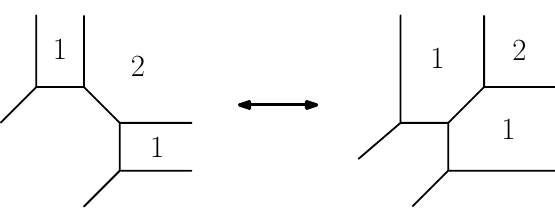
Figure 7. Two diagrams associated to D (2 ; 1; (cid:0) (cid:9)) 1 (cid:2) U(1) 2(cid:9) related by a